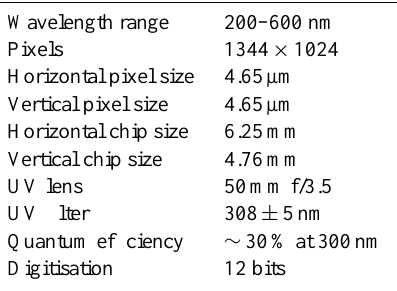
Table 1. Specifications of the Hamamatsu charge-coupled detector (CCD) chip and optics.